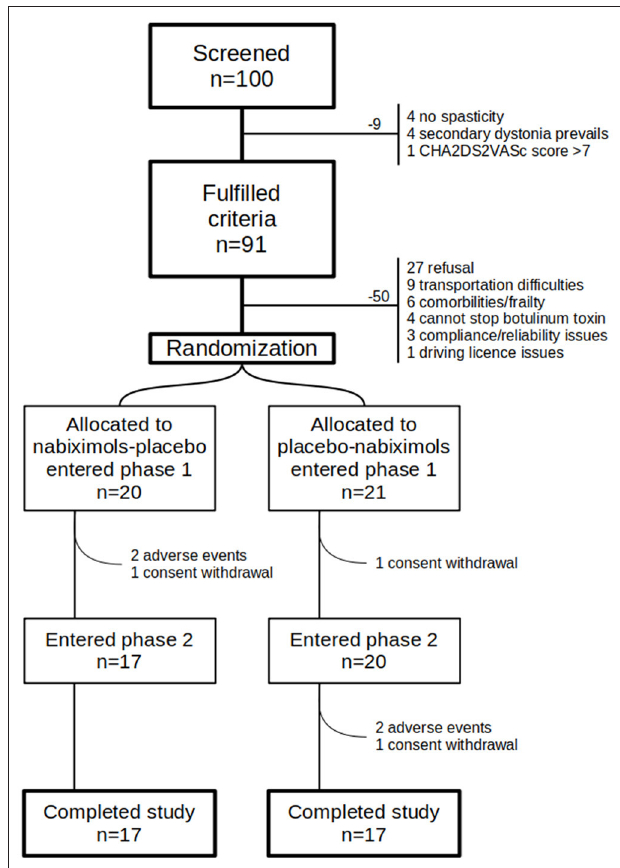
FIGURE 3 | Participants flow diagram. Graphical representation of patients flow. Many patients fulfilled inclusion/exclusion criteria but had to be excluded because of many reasons, mainly refusal.